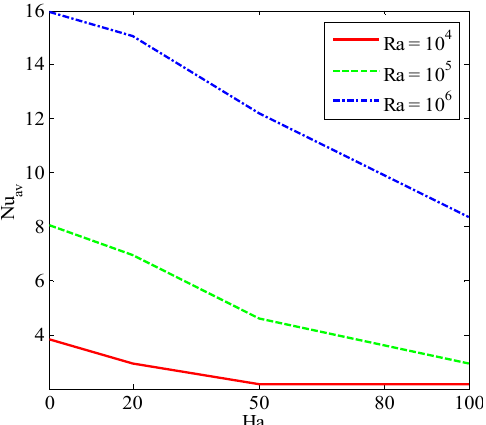
Figure 15. Variation of mean Nusselt number ( Nu av ) for various Rayleigh numbers ( Ra ) and Hartmann number ( Ha ) when ϕ = 0.04, n = 3, d = 10 nm, n = 3, λ = 0.5, and τ = 1.